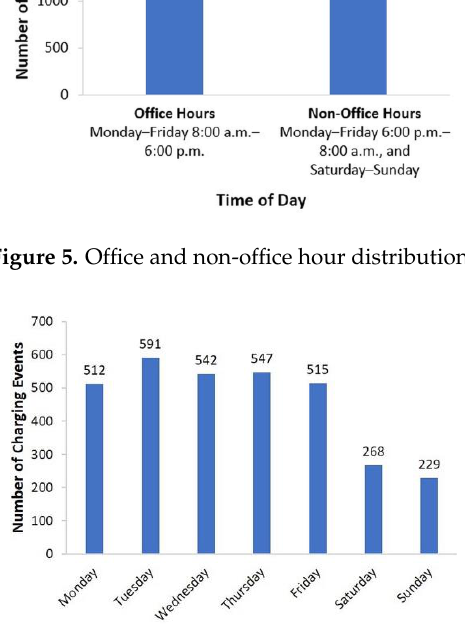
Figure 6. Distribution of charging events by day of the week.